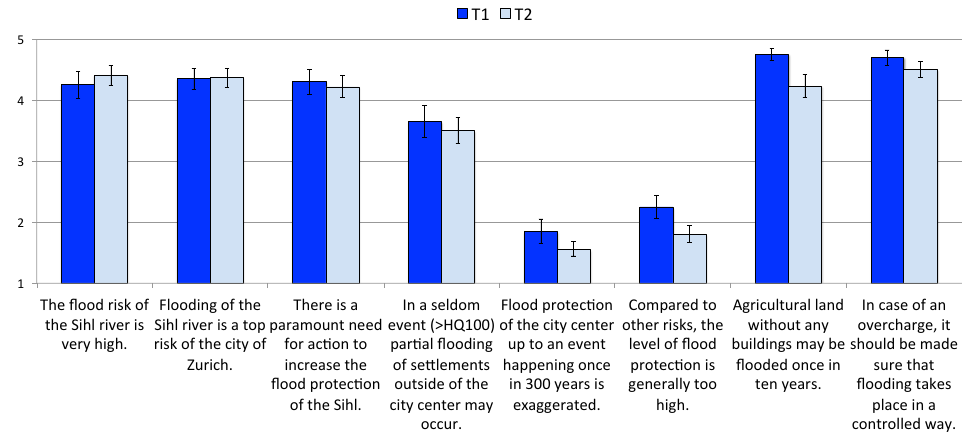
Fig. 6. Participants’ risk perception before (T1) and after (T2) the participatory assessment process. R ESPONDENT . Actually, for us, for our department, it was really clear which project is the right one (...) Well, it is sim- ply not thinkable to discharge the whole water through the city (laughing). But, of course, there are people concerned with environmental protection, and who knows what